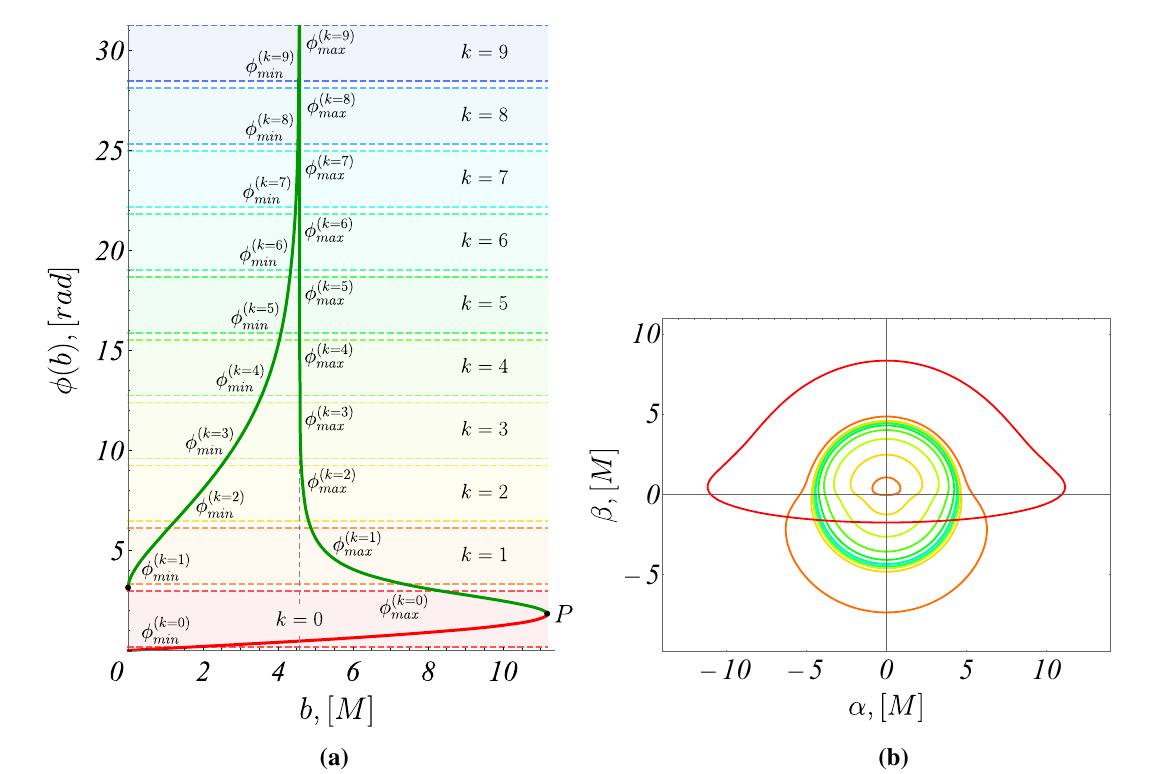
{ r = 5000 M , i = 80 ◦ } . In a we have denoted the value of the impact obs parameter of the photon sphere with a vertical dashed line